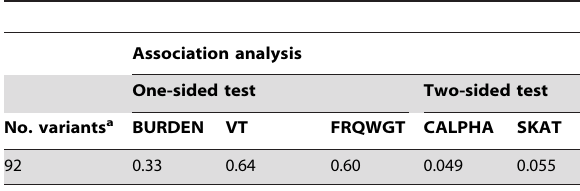
Table 3. Results of rare variant tests for PLB1 coding variants in the European RA case-control